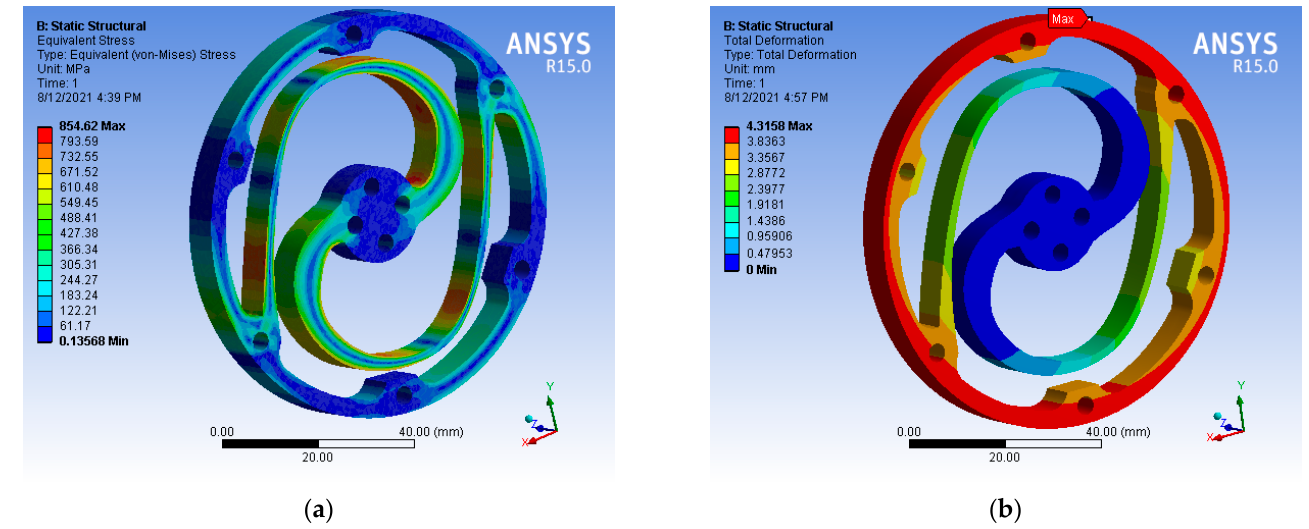
Figure 9. FEM results: ( a ) Module deformation (mm); ( b ) Von Mises stress (MPa).